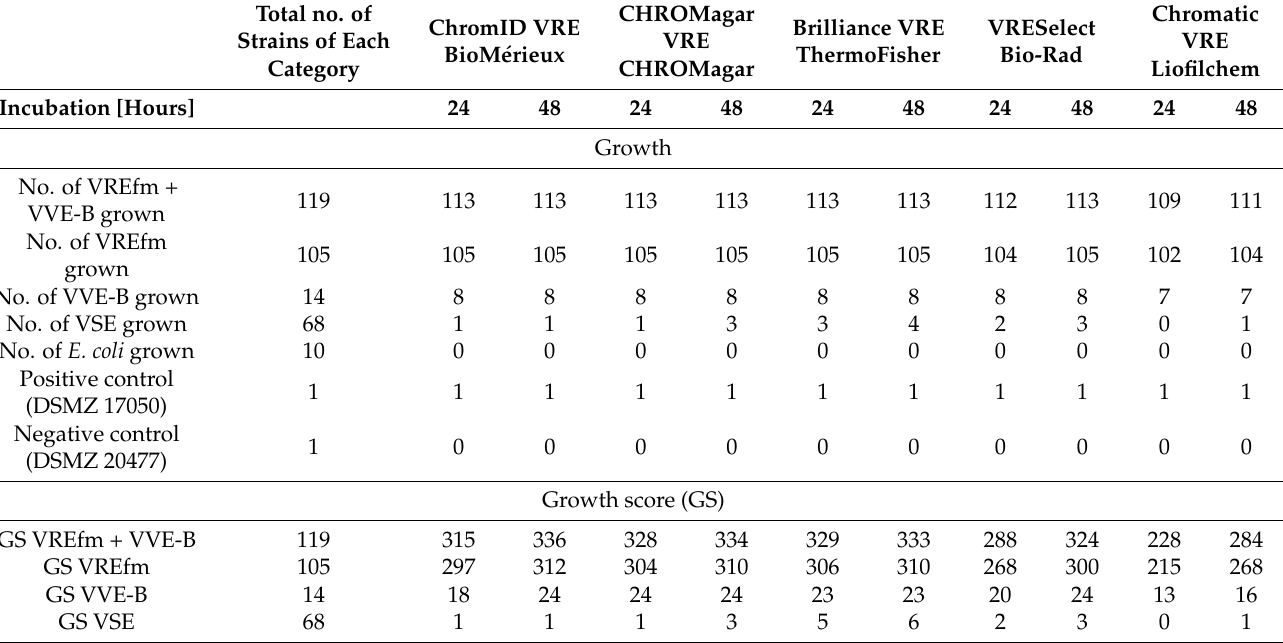
Table 1. Overview of general growth of E. faecium on the agar plates